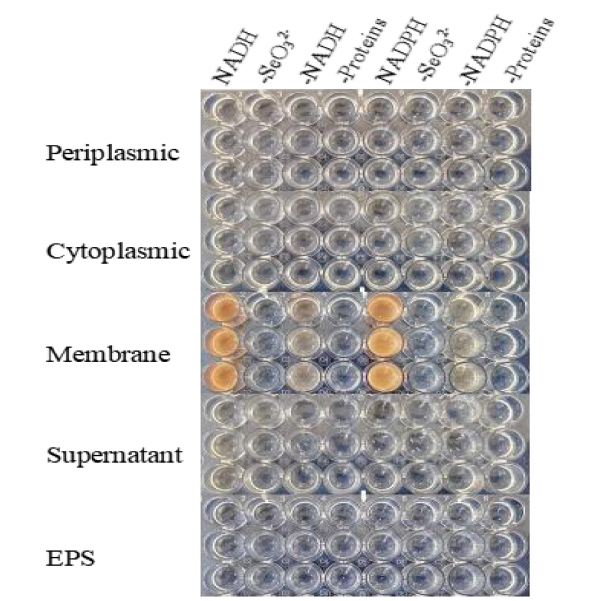
FIGURE 5 | In vitro SeO 3 2 − reducing activity assays on different subcellular fractions (cytoplasmic, periplasmic, and membrane), supernatant, and exopolysaccharide (EPS). All experiments were performed in duplicate, with addition of 2 mM SeO 32 − and 2 mM NADPH or NADH. While 3 following control negatives were performed: without protein fractions, without selenite, without NADPH or